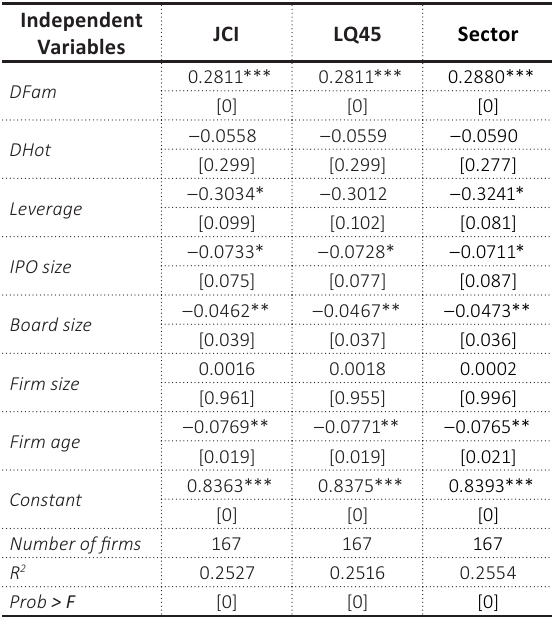
Table 4. Effect of family ownership on IPO